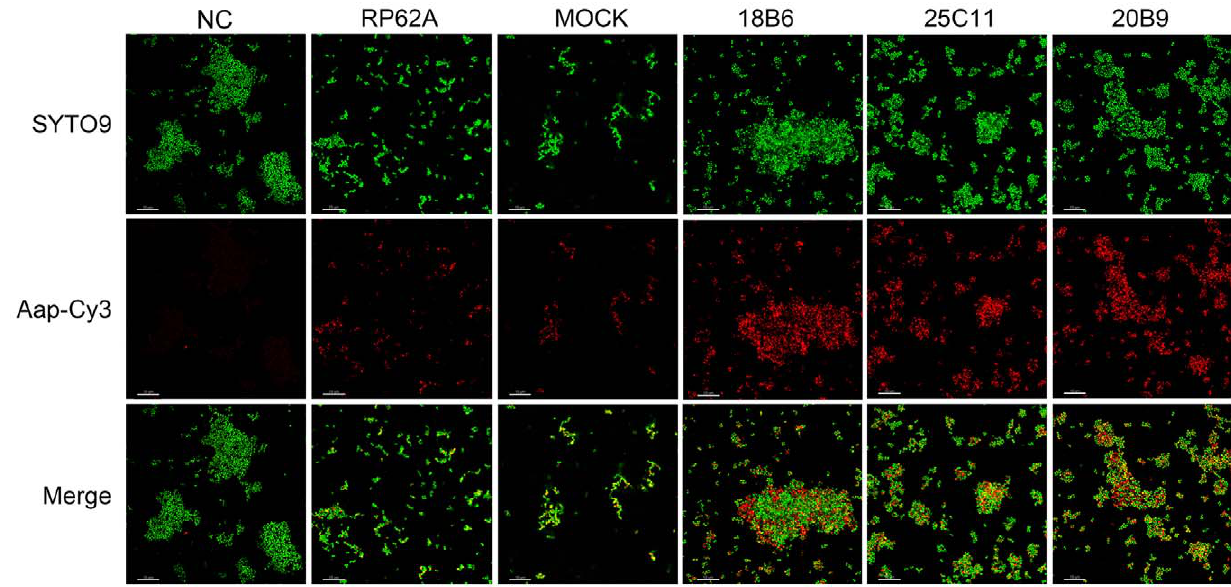
Figure 6. Aap expression in planktonic S.epidermidis . Aap expressed in planktonic S. epidermidis RP62A (cultured for 14 h) was probed with MAb 25C11 (10 ng/mL) and Cy3-conjugated secondary antibody (1:100 diluted, red). The bacteria were stained with SYTO9 (1 m M, green) and observed under a Leica TCS SP5 CLSM. ‘‘NC’’: negative control (the cell clusters formed in the presence of MAb 25C11 were probed with Cy3-conjugated secondary antibody alone to establish that the clusters no longer contained initially added MAb (10 m g/mL), that could cause false-positive immunofluorescence, after 14 h culture), ‘‘RP62A’’: untreated; ‘‘Mock’’: normal mouse IgG-treated.